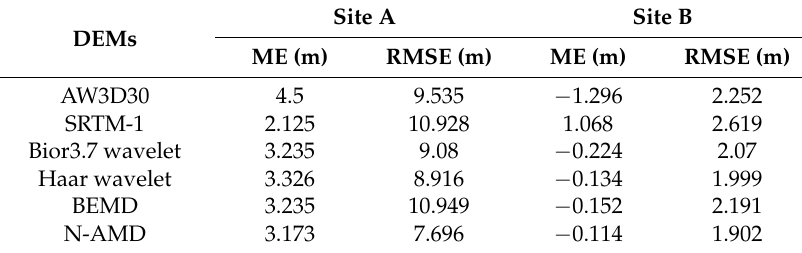
Figure 8. Enlarged images of the fused DEMs obtained using the Bior3.7 wavelet, Haar wavelet, BEMD, and N-AMD methods at ( a – d ) site A and ( e – h ) site B. The red shapes indicate irregular patches. Table 3. Accuracy statistics of original DEMs and fused